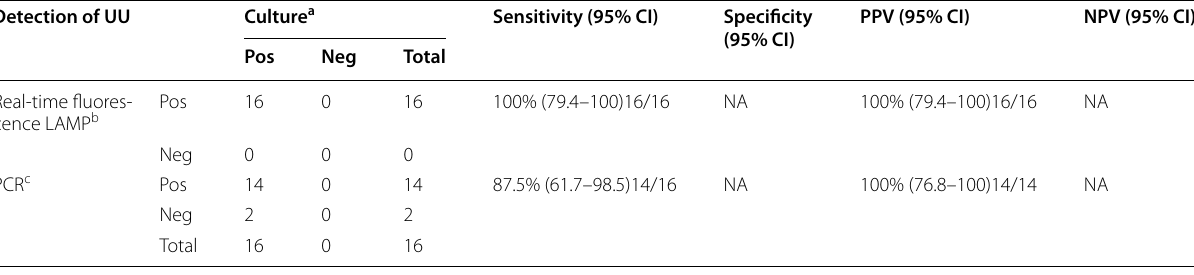
PPV positive predictive value, NPV negative predictive value a Culture was performed on UU medium. Pos indicates that a UU strainwas isolated, and Neg indicates that no UU strain was isolated b Real-time fluorescence LAMP reaction was confirmed using a real-time quantitative PCR analyzer (ABI 7500). Pos indicates that amplification occurred in the UU LAMP assay, and Neg indicates that amplification did not occur in the UU LAMP